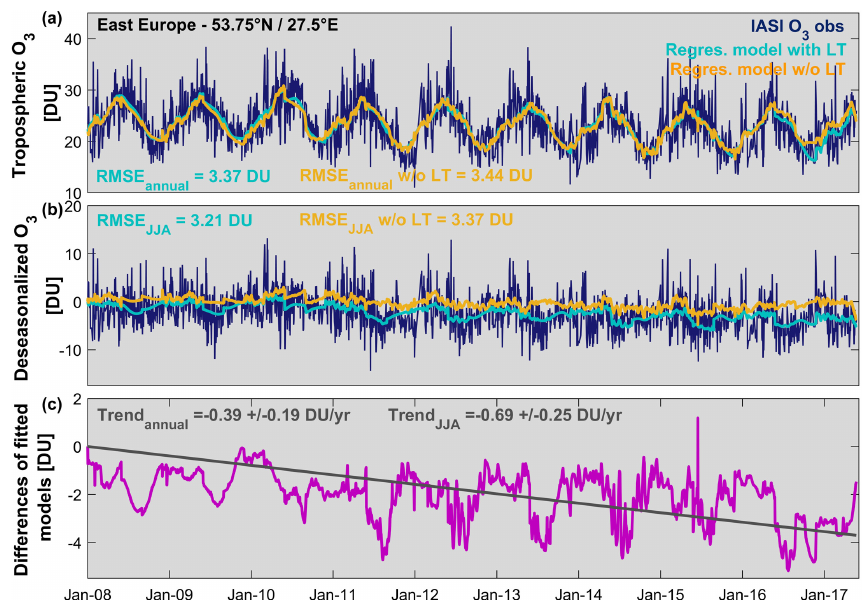
Figure 3. (a) Example of daily time series of IASI O 3 measurements (dark blue) and of the fitted seasonal regression models with (light blue) and without (orange) the linear term in the troposphere. Daily time series (b) of the deseasonalized O 3 (observations and regression models) and (c) of the difference of the fitted models with and without the linear trend term as well as the adjusted annual trend (pink and grey lines, respectively; c ; given in DU). The RMSE (annual and for the JJA period in DU) and the trend values (annual and for the JJA period in DUyr − 1 ) are also indicated.